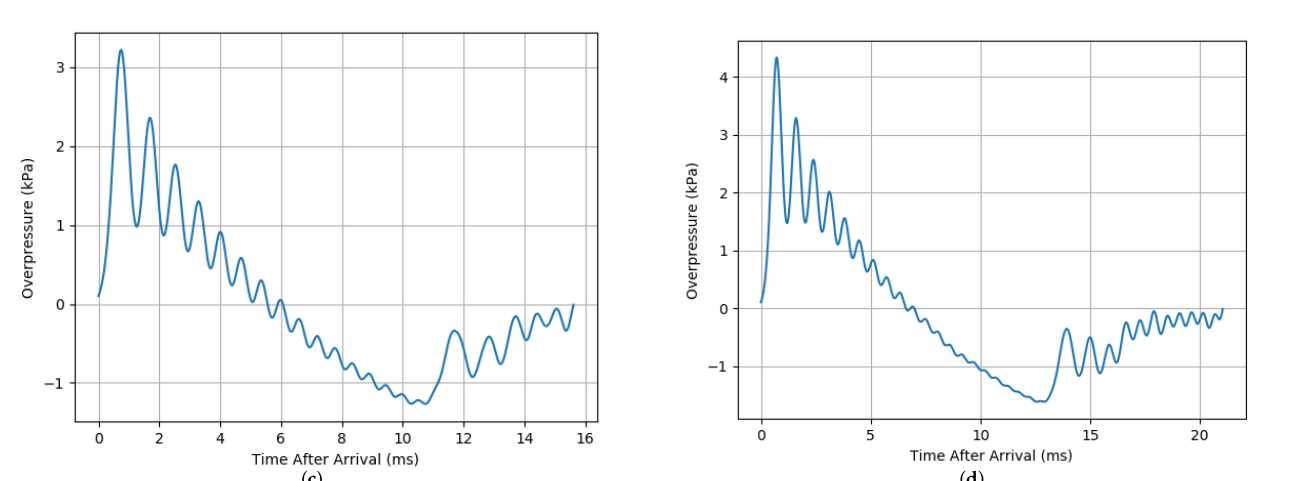
Figure 4. Pressure time histories from four simulations of hemispherical TNT detonation at 36.576 m (120 ft): ( a ) 0.06123 kg (0.135 lb), ( b ) 0.45359 kg (1 lb), ( c ) 0.90718 kg (2 lb), and ( d ) 1.81436 kg (4 lb).